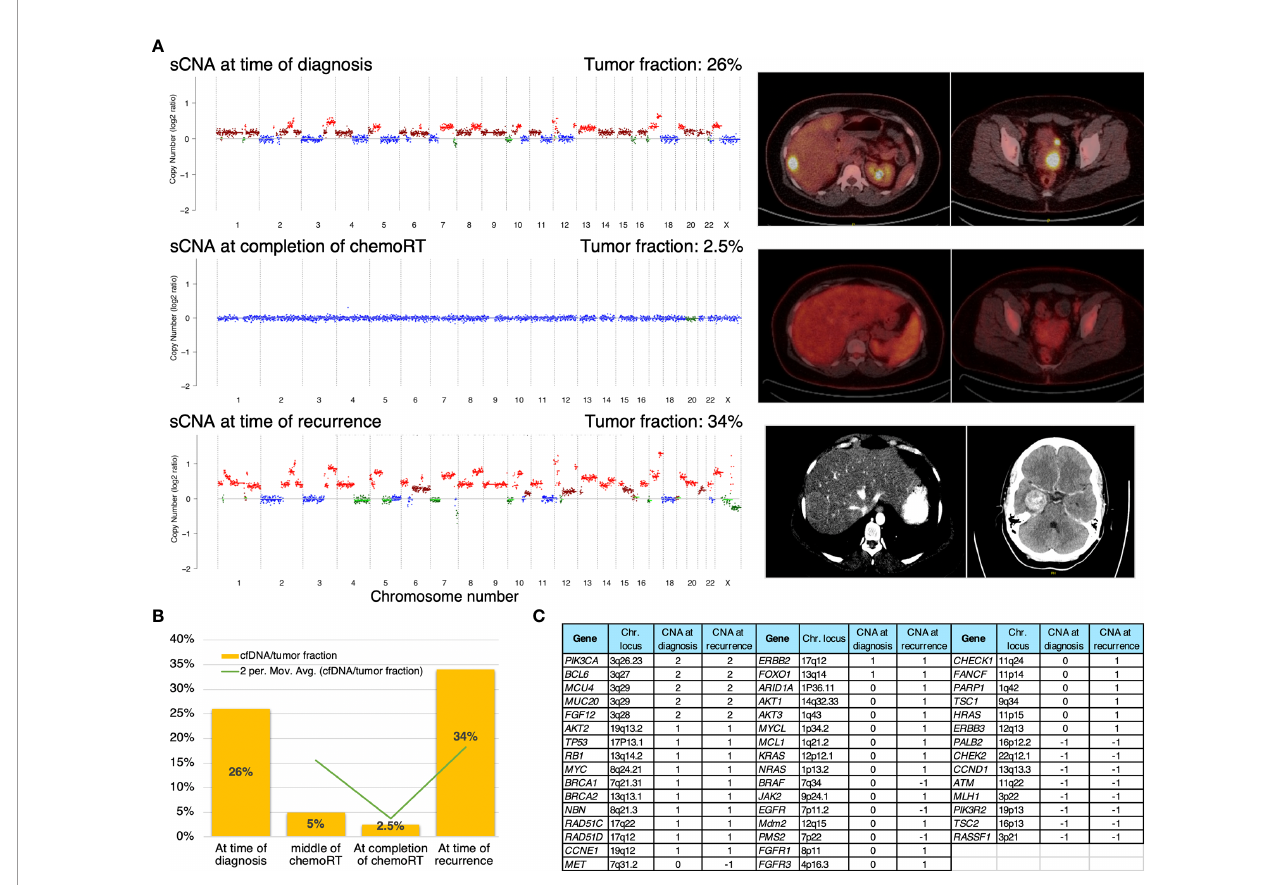
FIGURE 4 | (A) sCNA at three different time points (left panels) with copy number (log2 ratio) indicated on the y-axis and chromosome on the x-axis. PET/CT images corresponding to the time of liquid biopsy collections (right panels). (B) Diagrammatic representation of the serial trend of tumor fraction at diagnosis, during treatment, and at the time of recurrence. (C) A descriptive comparison of selected gene-level copy number data between time of diagnosis and time of recurrence. -2/-1/0/1/2 refer for homozygous deletion, heterozygous deletion, copy neutral, low gain, and high ampli fi cation,